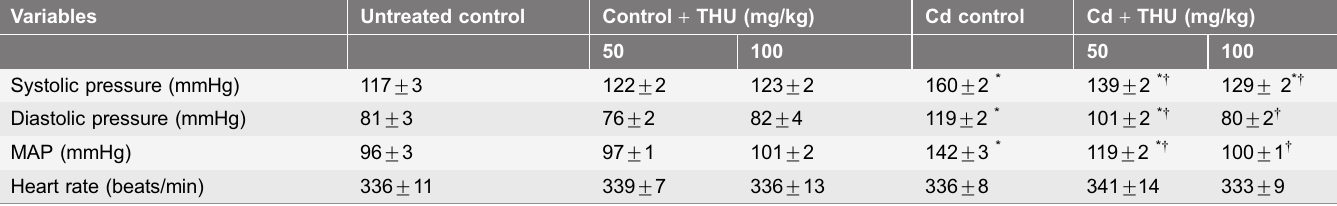
Table 1. Effect of THU on arterial blood pressure and heart rate in all experimental groups. Variables